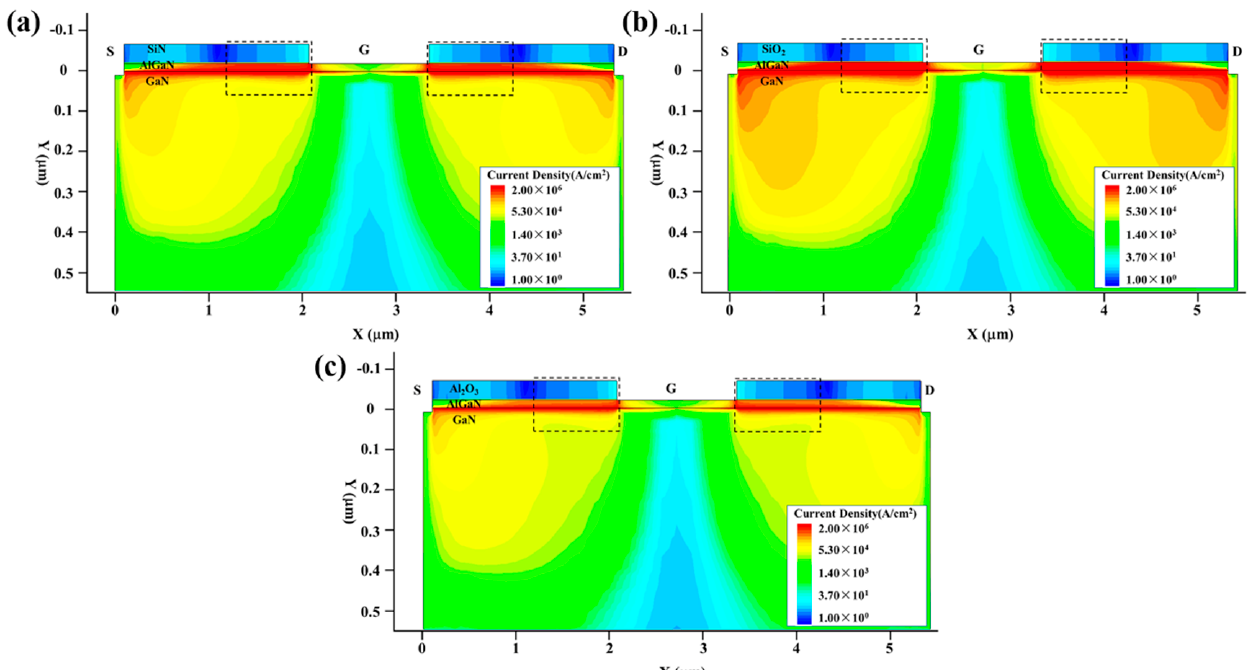
Figure 12. The current density distribution of the GaN HEMT at the moment of burnout with different passivation layers: ( a ) SiN; ( b ) SiO 2 ; ( c ) Al 2 O 3 .